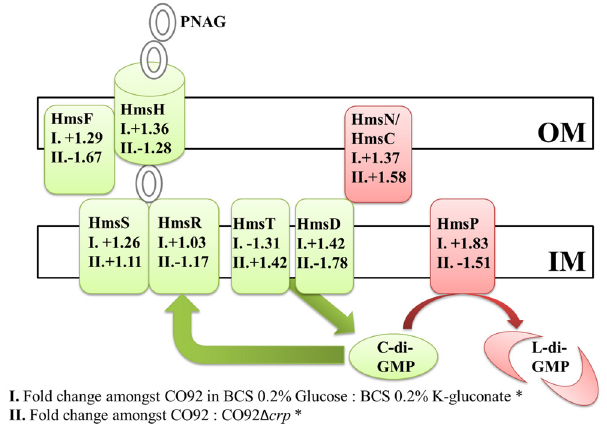
Fig 6. Semi-quantitative RT-PCR of the Y . pestis Hms System. Depiction of semi-quantitative RT-PCR fold changes in expression of the Y . pestis Hms biofilm formation/regulation system following normalization to the gyrB gene. “ OM ” reflects the bacterial outer membrane; whereas, “ IM ” indicates the inner membrane. Factors highlighted in green represent characterized pro-biofilm factors. Factors colored in red have been shown to impair biofilm production. I . Fold changes in mRNA abundance amongst CO92 grown in BCS medium supplemented with 0.2% glucose to CO92 cultured in BCS supplemented with 0.2% K-gluconate. II . Fold changes in mRNA abundance of CO92 to CO92 Δ crp when grown in HIB